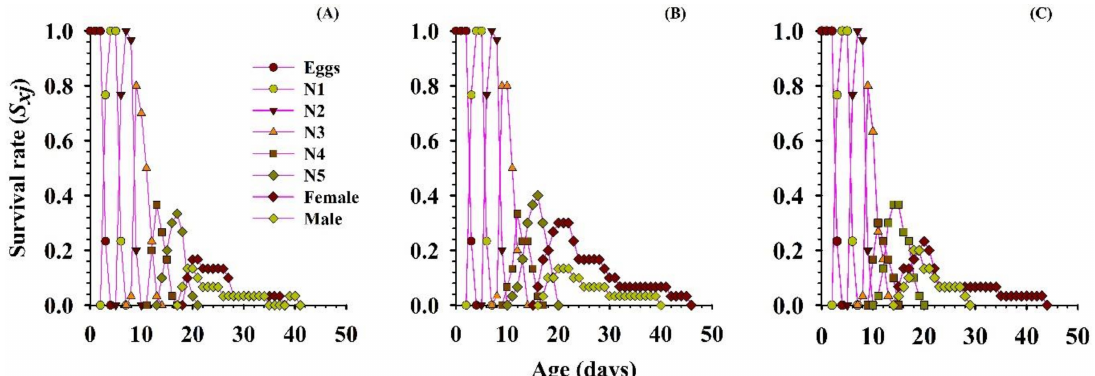
Figure 4. Influence of three di ff erent densities of P. gossypiella eggs (( A ) = 5 eggs, ( B ) = 10 eggs and ( C ) = 15 eggs) on the age-stage-specific survival rate ( s